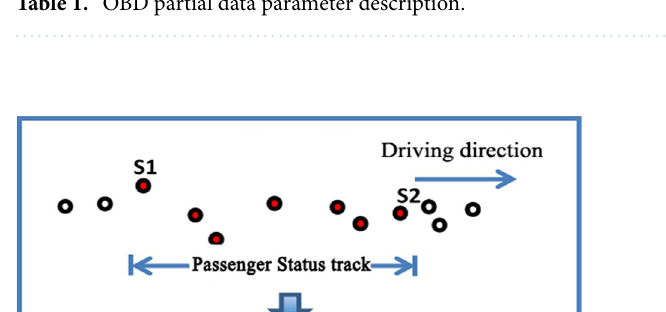
Table 1. OBD partial data parameter description.